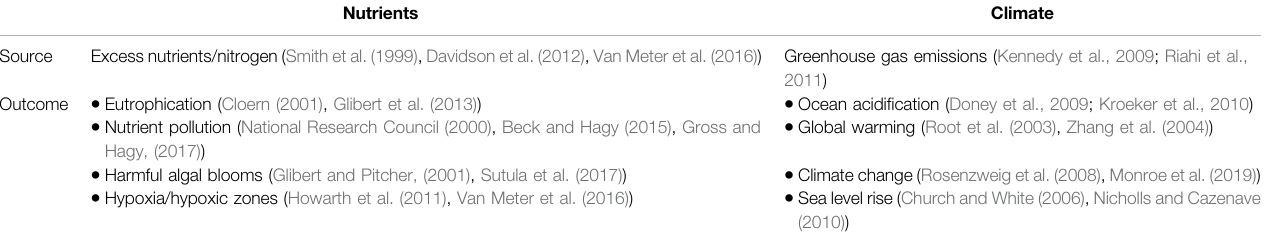
TABLE 1 | Different terminology used in framing environmental challenges around either the source or the outcome, with a couple of papers as examples of each. Note that these citations often used more than one of the terms in their issue category. Nutrients